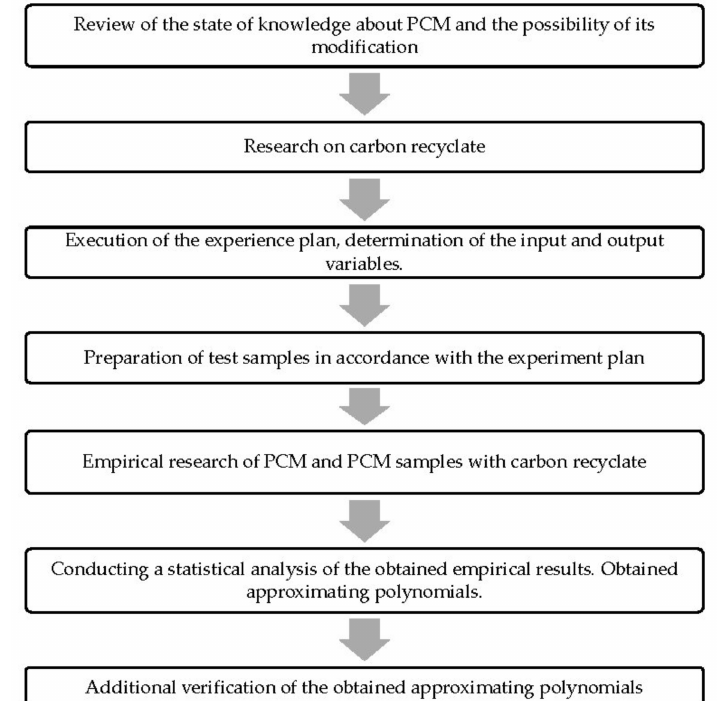
Figure 1. Scheme of the research